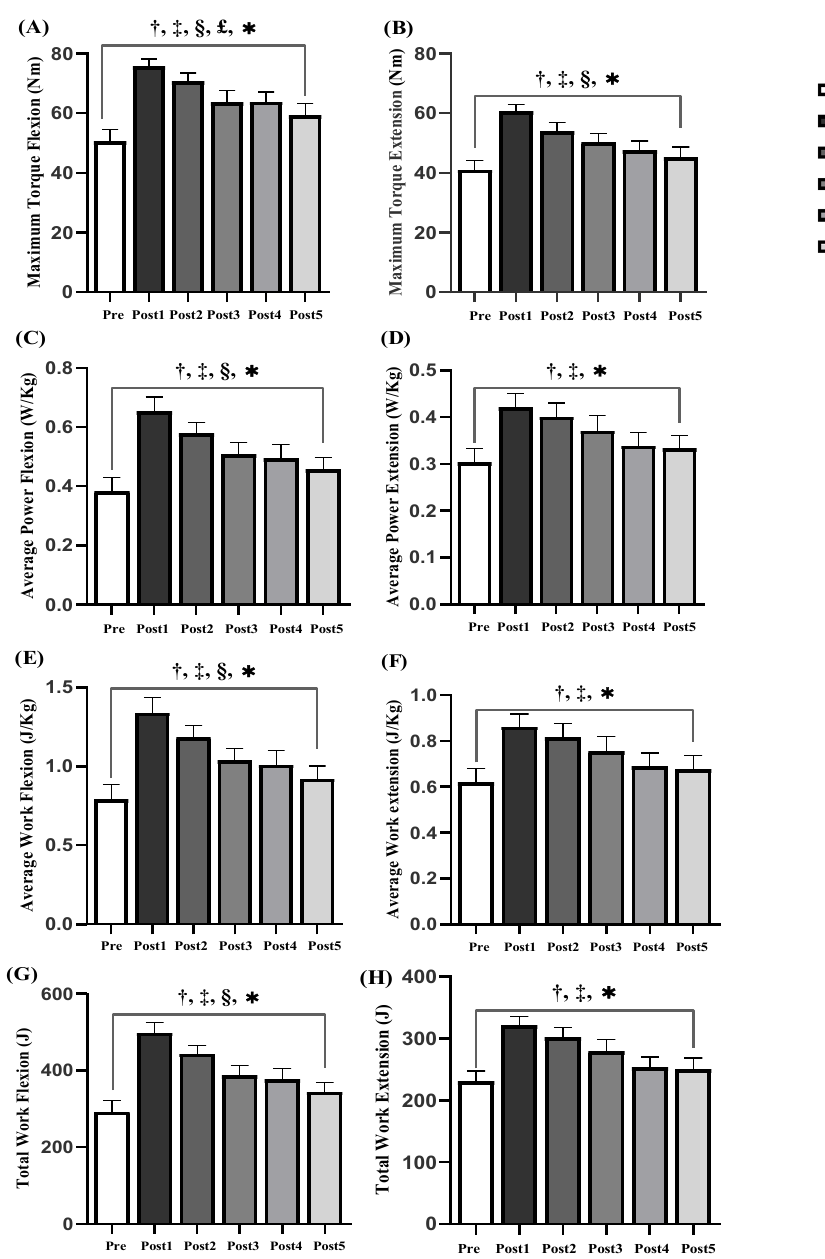
Figure 5. Comparison of flexion and extension (Ext/Flex) motion parameters of shoulder joint before and after acupuncture ( n = 17): ( A ) Maximum Torque of Flex, ( B ) Maximum Torque of Ext, ( C ) Average Power of Flex, ( D ) Average Power of Ext, ( E ) Average Work of Flex, ( F ) Average Work of Ext, ( G ) Total Work of Flex, ( H ) Total Work of Ext. Note: *: Significant shoulder joint Ext/Flex muscle endurance ( p < 0.05). †: significant from pre and post1 ( p < 0.05). ‡: significant from pre and post 2 ( p < 0.05). §: significant from pre and post 3 ( p < 0.05). £: significant from pre and post 4 ( p <